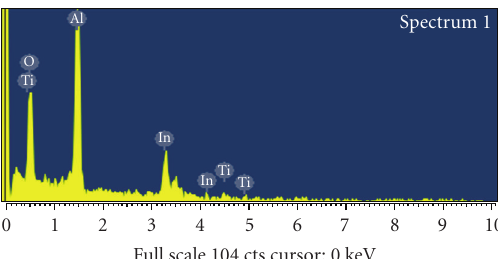
Figure 7: EDS spectrum for the TiO 2 film shown in Figure 6(b).